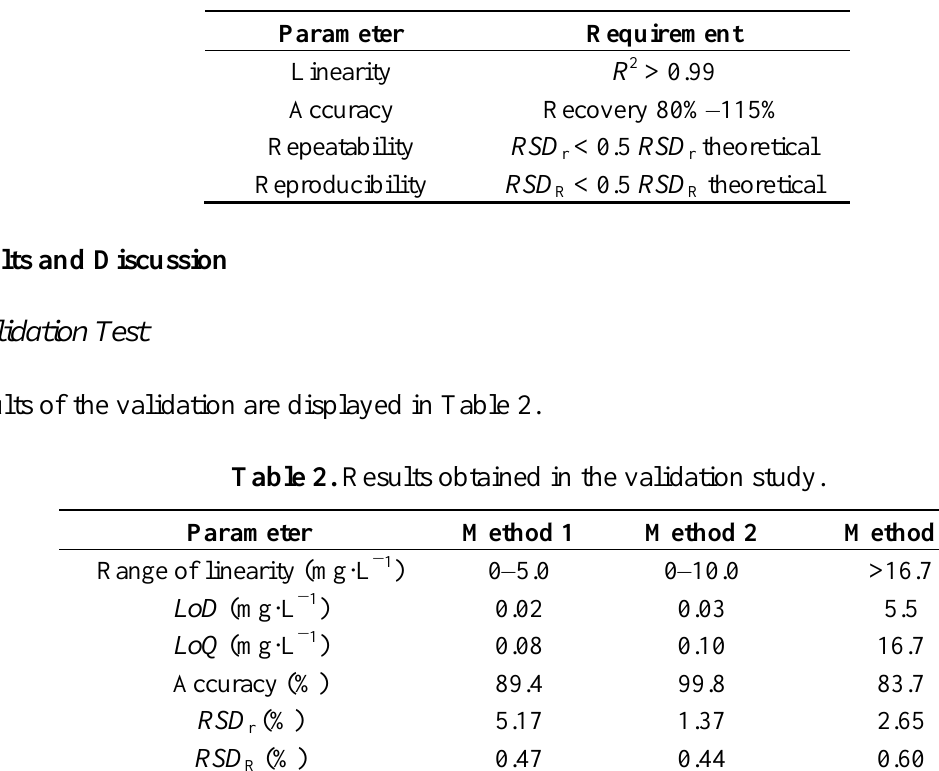
Table 1. Acceptance criteria established in the validation study.